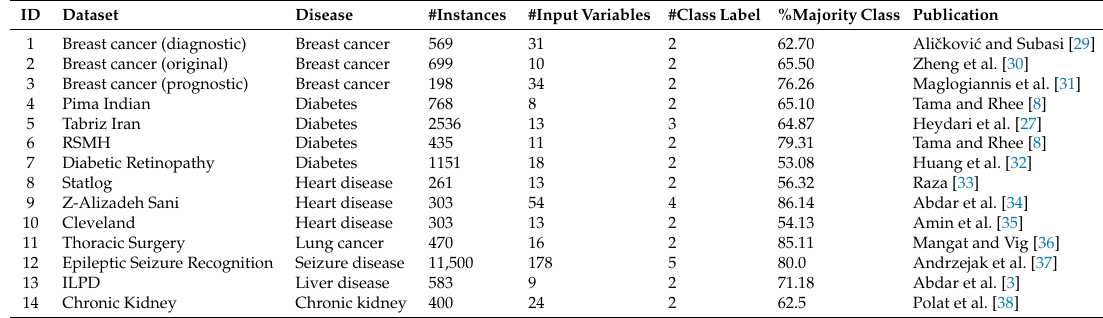
Table 1. Recapitulation of 14 datasets used in this benchmark